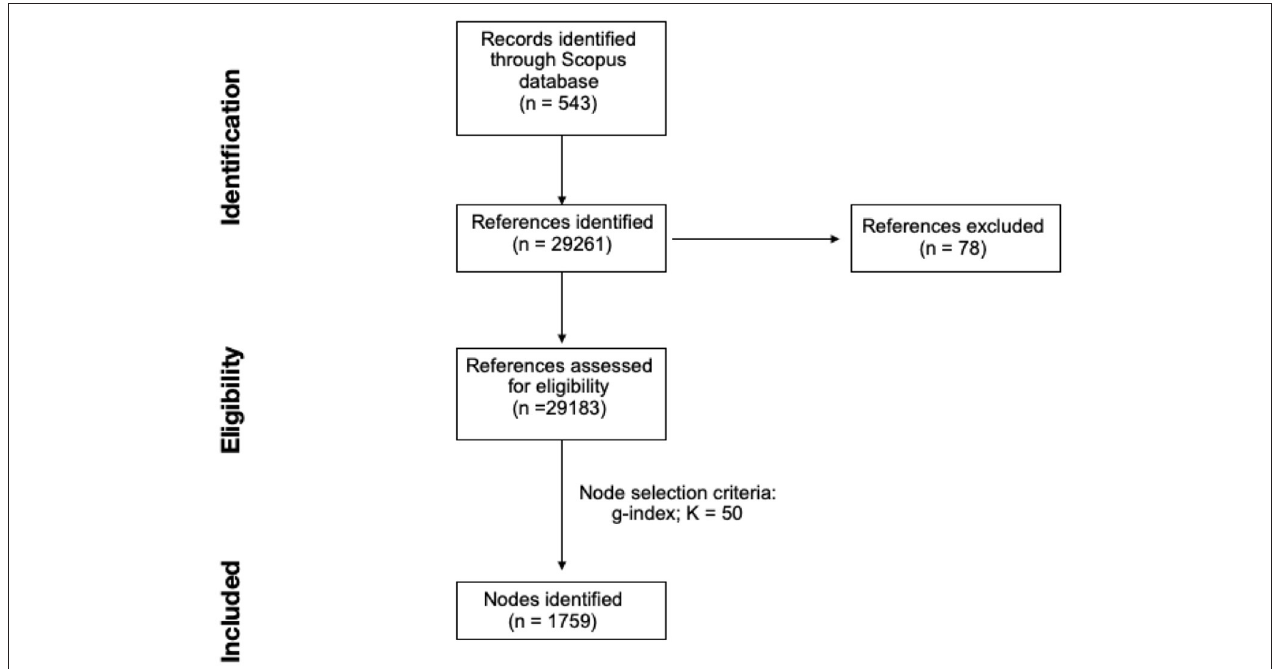
FIGURE 1 | Study flow